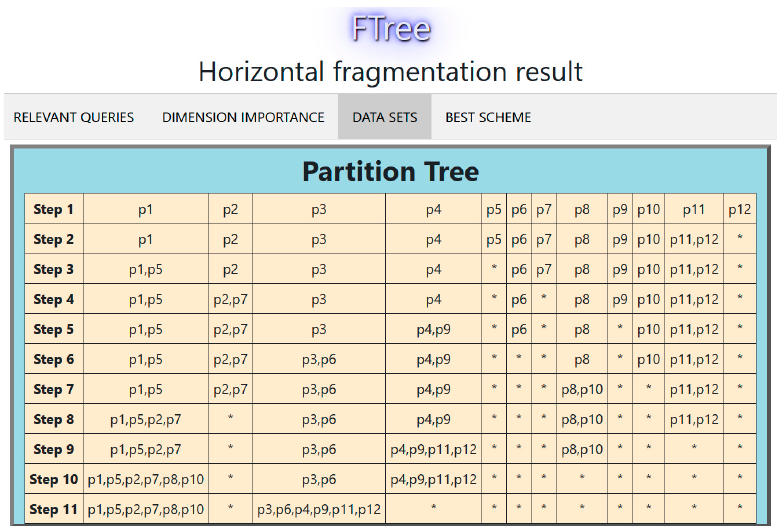
Figure 9. Partition tree for the second experiment with the tourist DW.